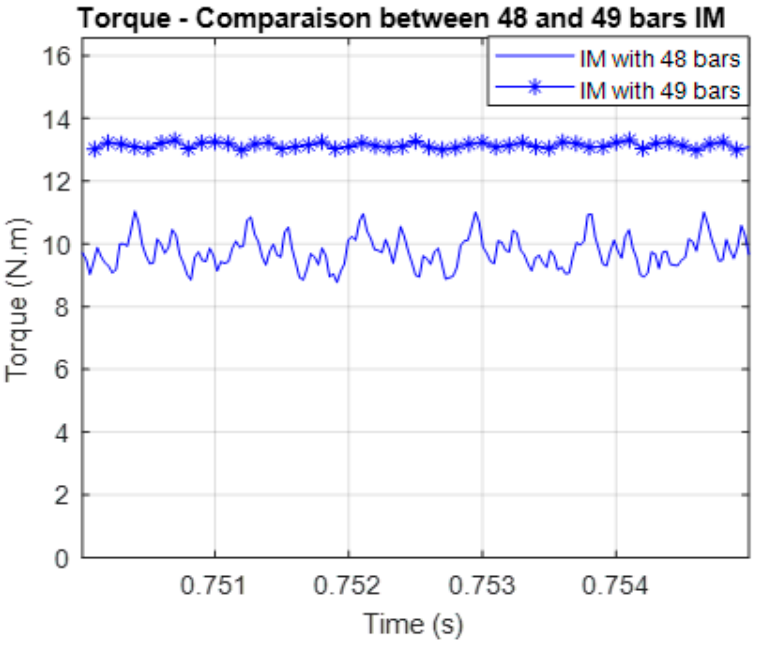
Figure 6. Comparison of the developed torque with 48 and 49 bars, three-phase